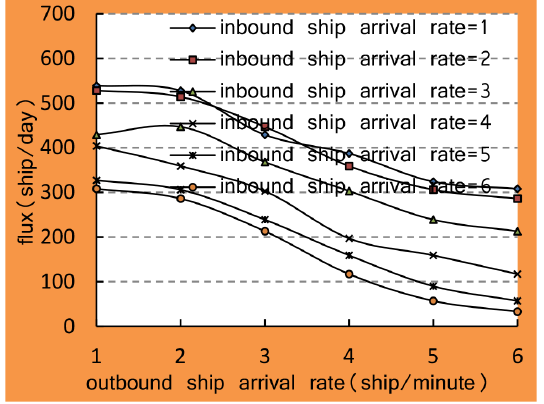
Figure 11. Traffic flux of waterway system and outbound ship arrival rate as a function at variable inbound ship arrival rate (when prohibit